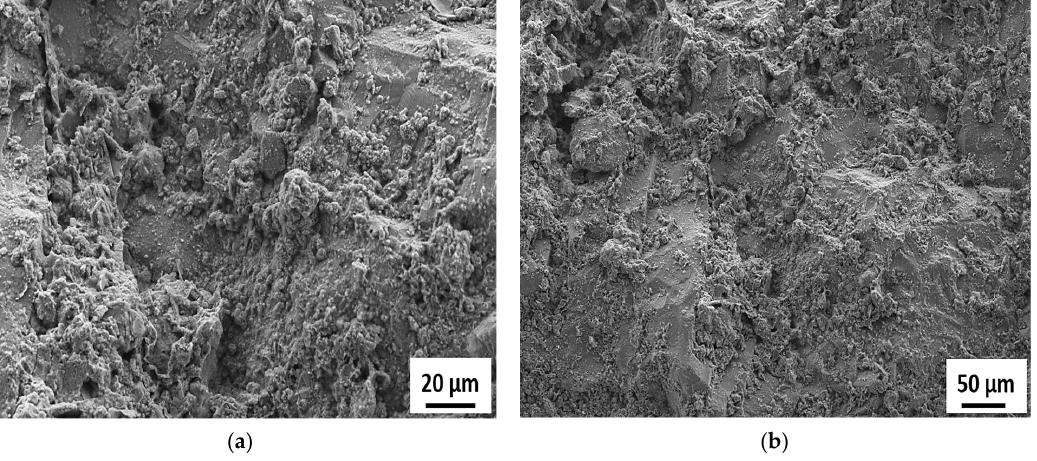
Figure 18. SEM images of specimens incorporating Shalozan aggregates ( a ) 20 µm (Mag. = 500×) ( b ) 50 µm (Mag. = 180×).